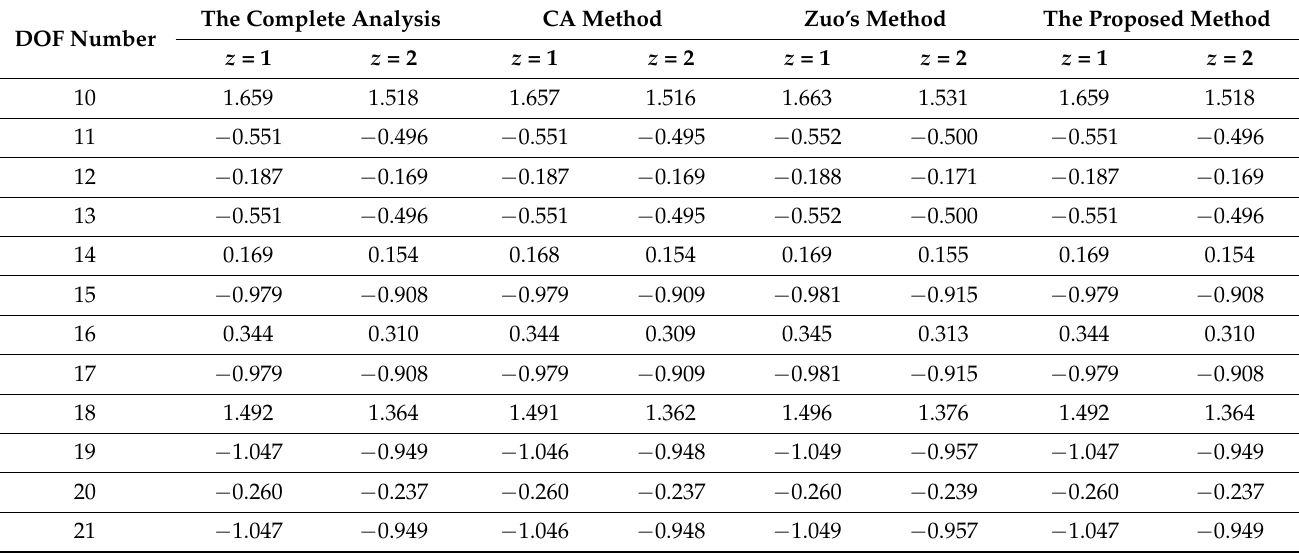
Table 6. Displacement sensitivities for modification type 1 when z = 1 and z = 2 ( × 10 − 5